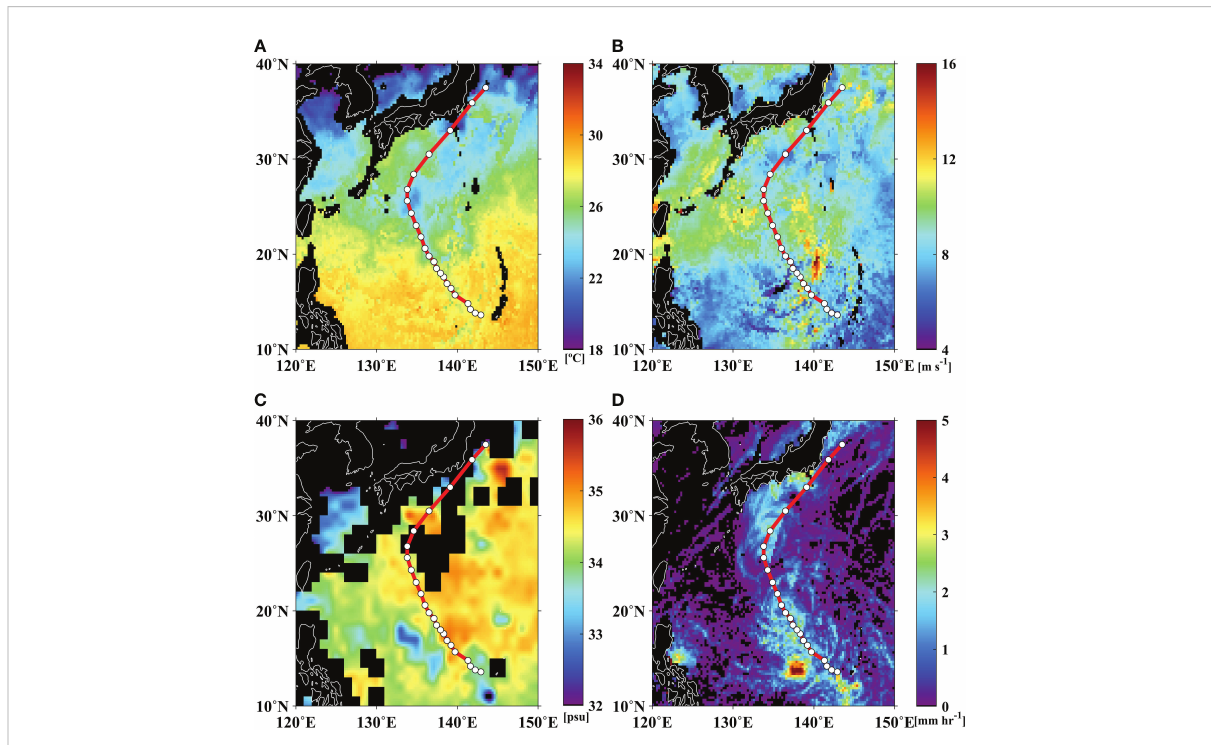
FIGURE 7 Spatial distributions of (A) minimum of sea surface temperatures (°C), (B) mean of wind speed (m s -1 ), (C) minimum Aquarius Sea surface salinity (psu), and (D) mean of precipitation rates (mm h -1 ) during Typhoon Wipha passage from 10 – 16 October,